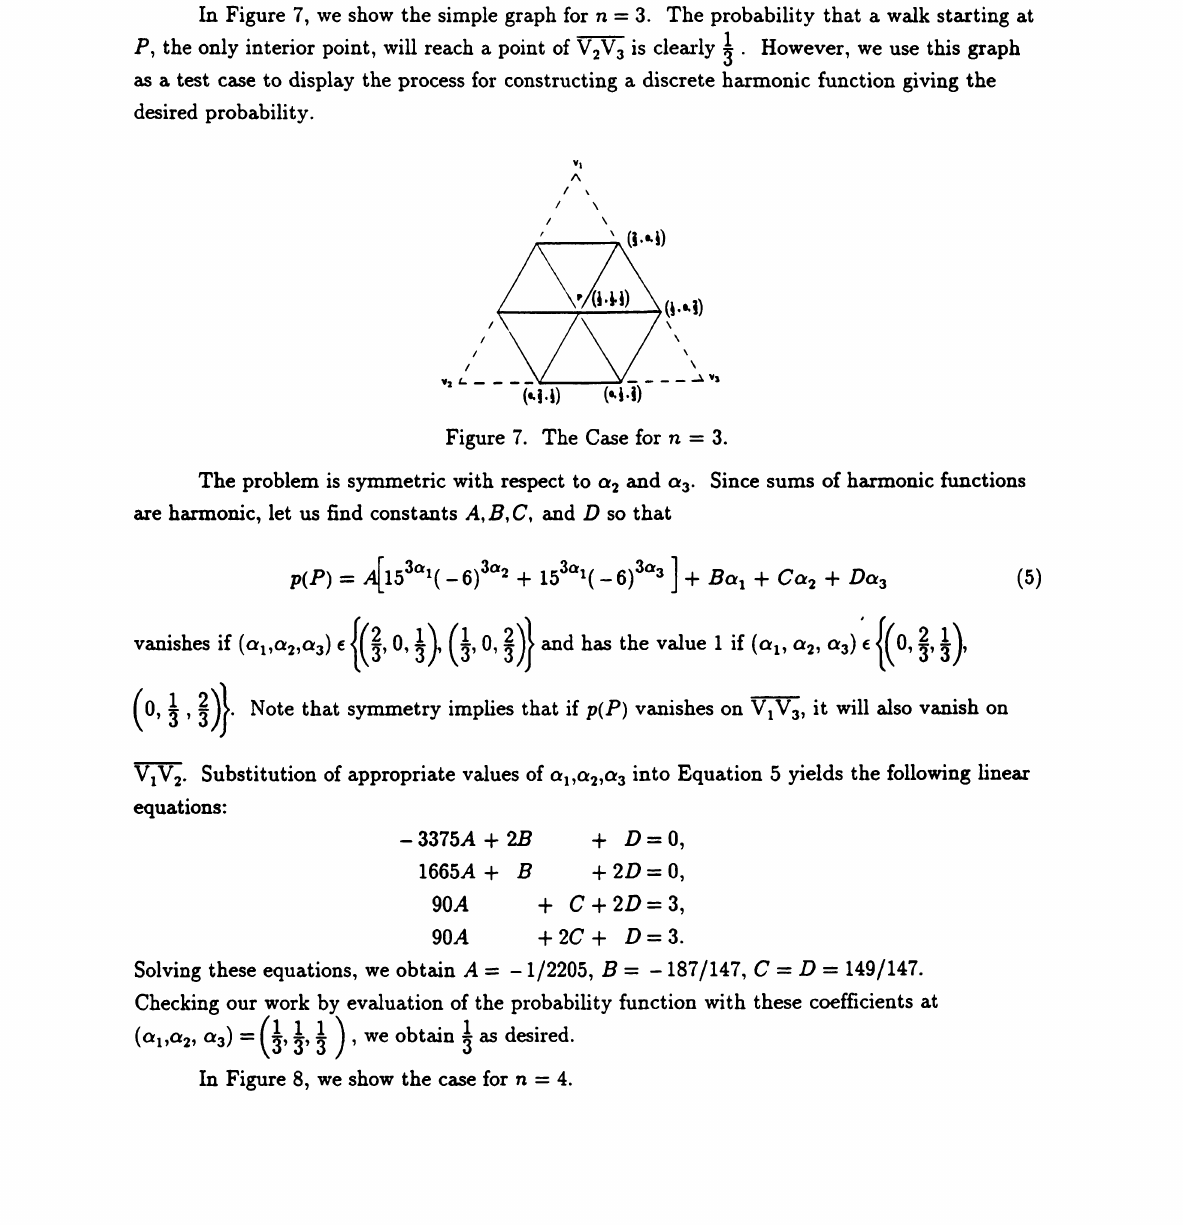
Table 1. Values of a,D,b.